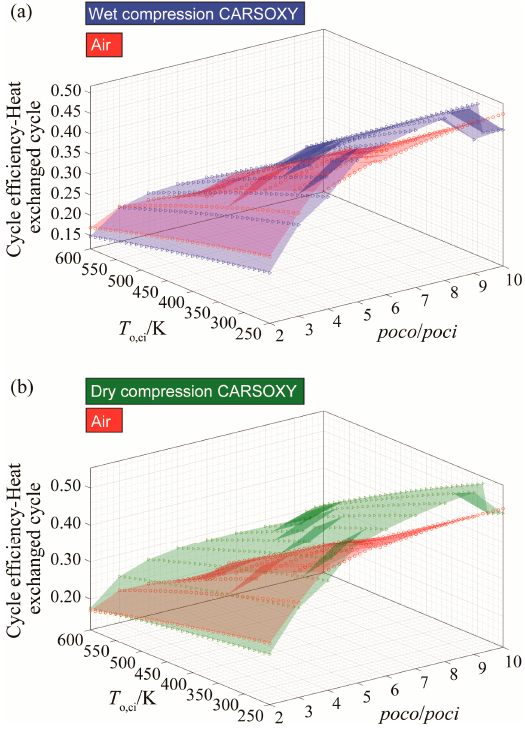
Figure 3. Efficiency results for the heat exchanged cycle using ( a ) wet compression and ( b ) dry compression.